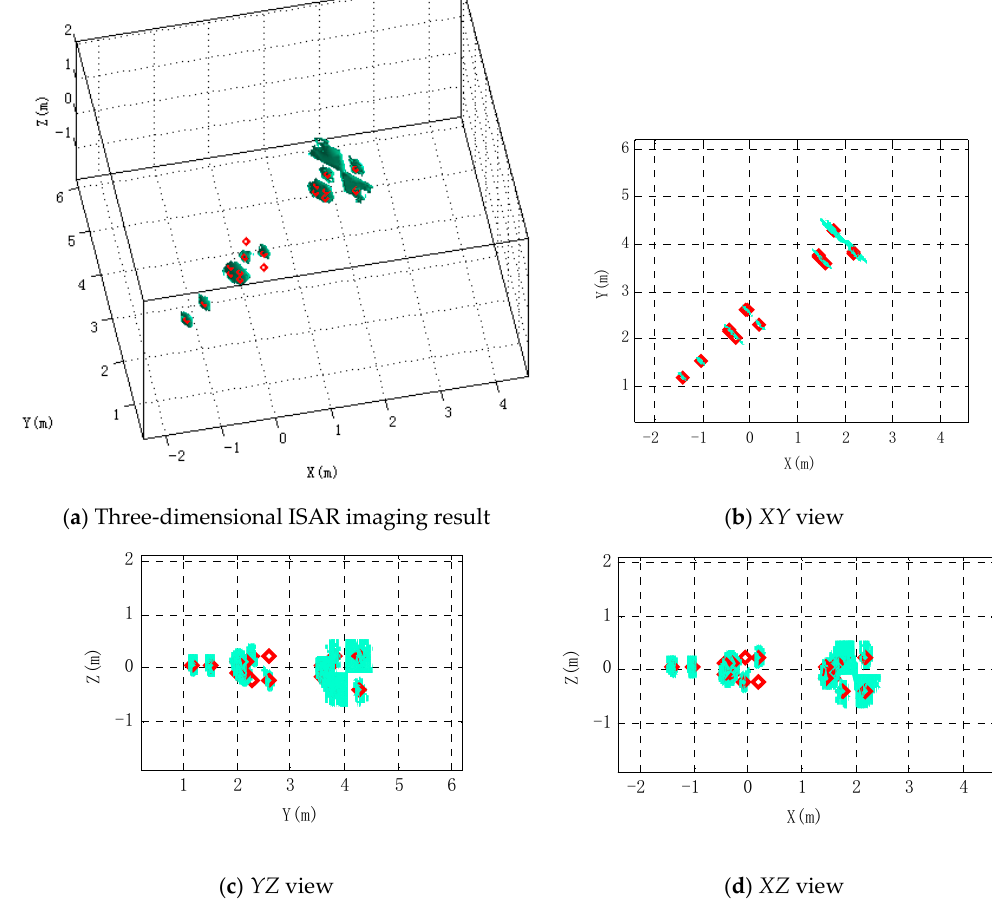
Figure 10. Three-dimensional ISAR imaging result and its three views using the proposed method. Diamonds show the true position of scattering centers.